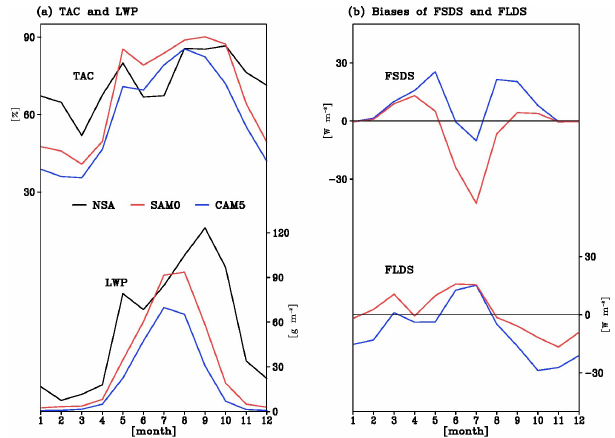
Figure 2. Annual cycles of total cloud fraction (TAC, upper part in a ) and liquid water path (LWP, bottom part in a ) from the cli- matology of ground-based cloud and radiation measurements at the North Slope of Alaska (NSA) Barrow site (black line), SAM0 (red line), and CAM5 (blue line). Biases of surface downward SW flux (FSDS, upper part in b ) and surface downward longwave flux (FLDS, bottom part in b ) of SAM0 (red line) and CAM5 (blue line) against the climatology of ground-based cloud and radiation mea- surements at the NSA Barrow site. The NSA Barrow site obser- vations were averaged from 1998 to 2010, and the model results are the means of AMIP simulation results for 36 years from Jan- uary 1979 to February